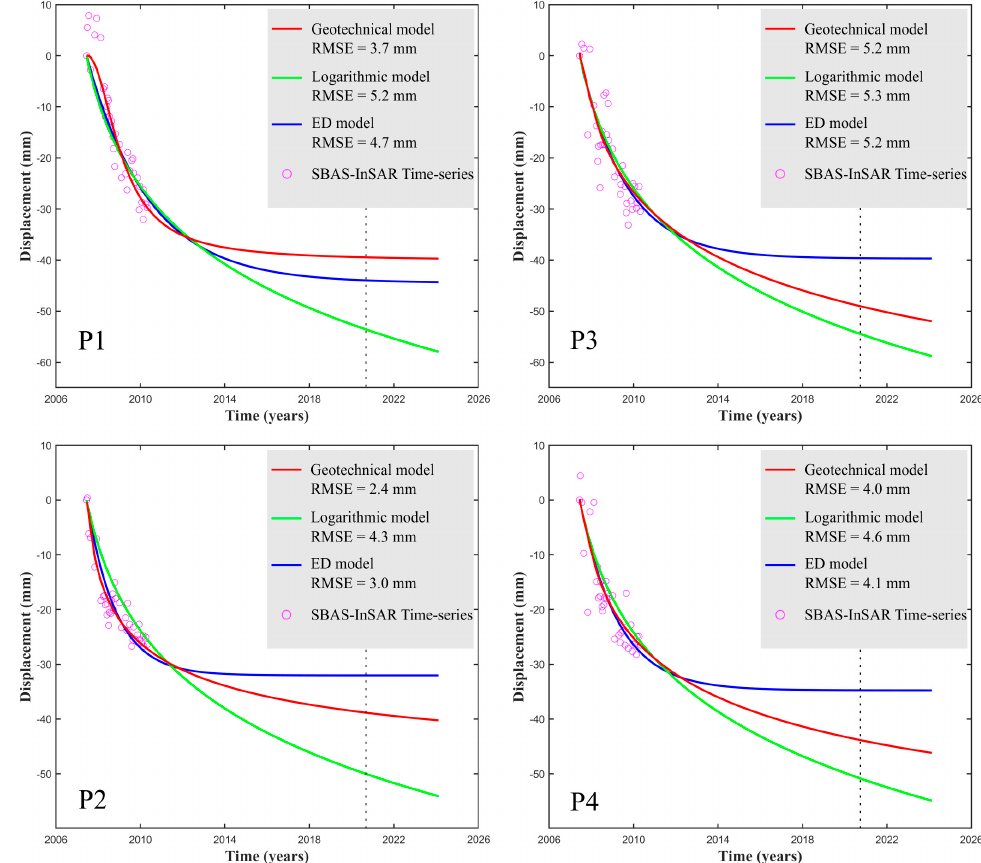
Figure 15. The plots of the ENV (vertical) deformation time-series relative to the four pixels, labeled as P1, P2, P3, and P4, are shown. The ENV deformation time-series are plotted in pink circles, whereas the corresponding best-fit geotechnical models, logarithmic models, and exponential decay models are plotted by continuous red, green, and blue lines, respectively. The black vertical dotted lines correspond to the present stage (July